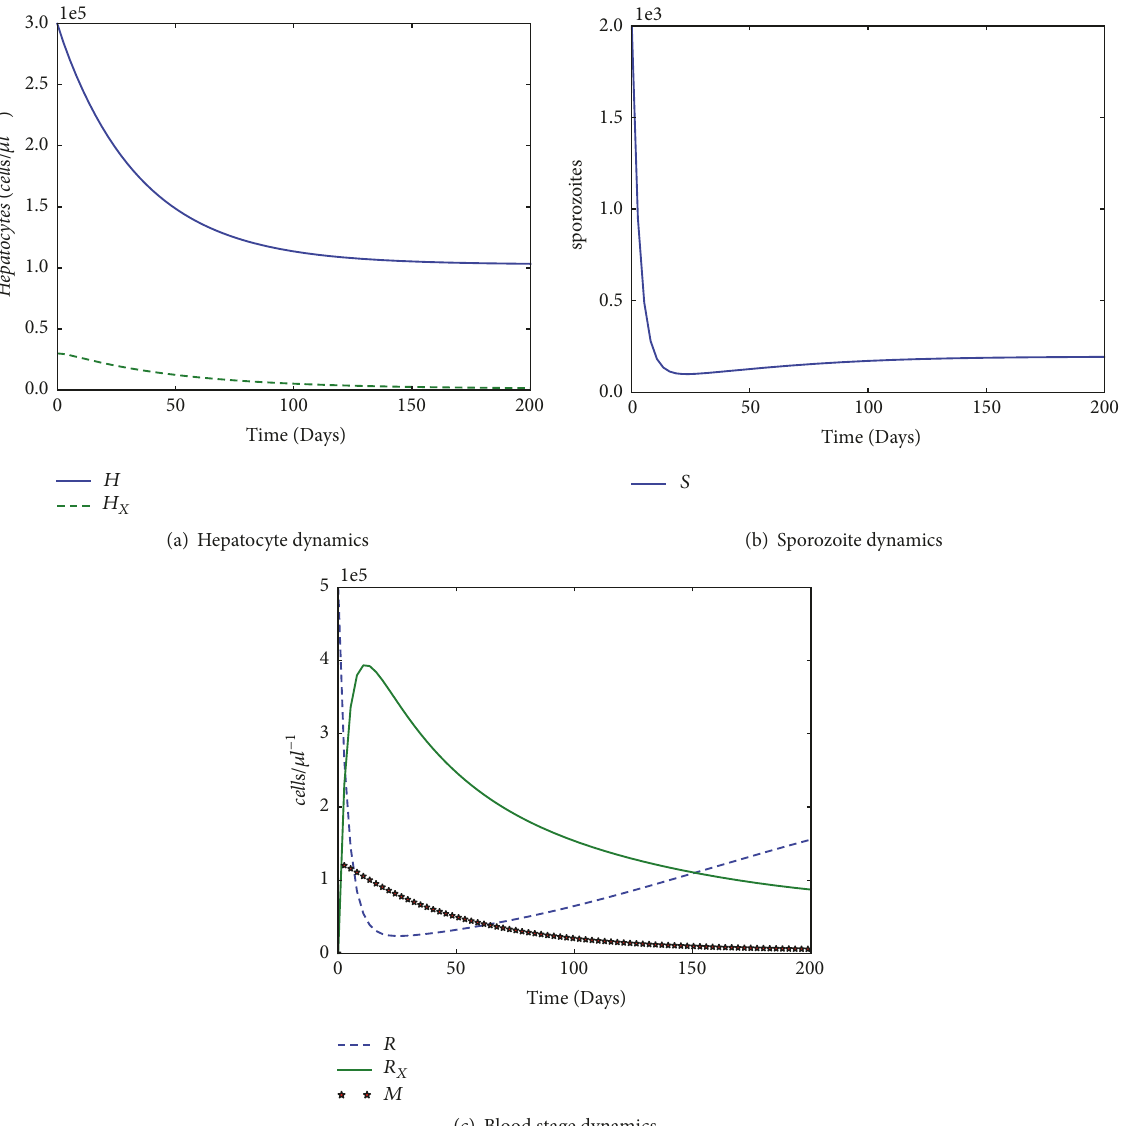
Figure 3: Graphs showing the simulation of in-host malaria model (1) when the model 𝑅 0 = 0.22866 < 1 . Figures (a) and (b) show model dynamics at the liver stage. The chosen initial conditions are 𝐻0 = 300000 , 𝐻 𝑋 0 = 20000 , 𝑅0 = 500000 , 𝑅 𝑋 0 = 50 , 𝑍0 = 300000 , 𝑆0 = 2000 , and 𝑀 = 70 . Used parameter values are given in Table